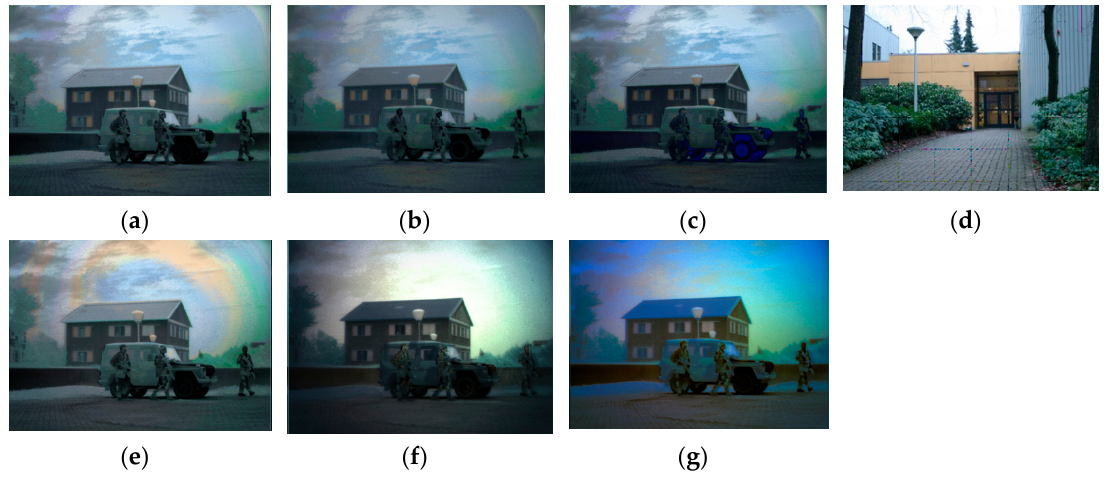
Figure 16. Results from color transformations derived from the scene shown on the right ( d ) with different sensor settings: ( a ) CTN method; ( b ) LFF method; ( c ) SHT method; ( d ) scene used for training the color transformations; ( e ) CTN2 method; ( f ) SCF method; ( g ) R3DF method.